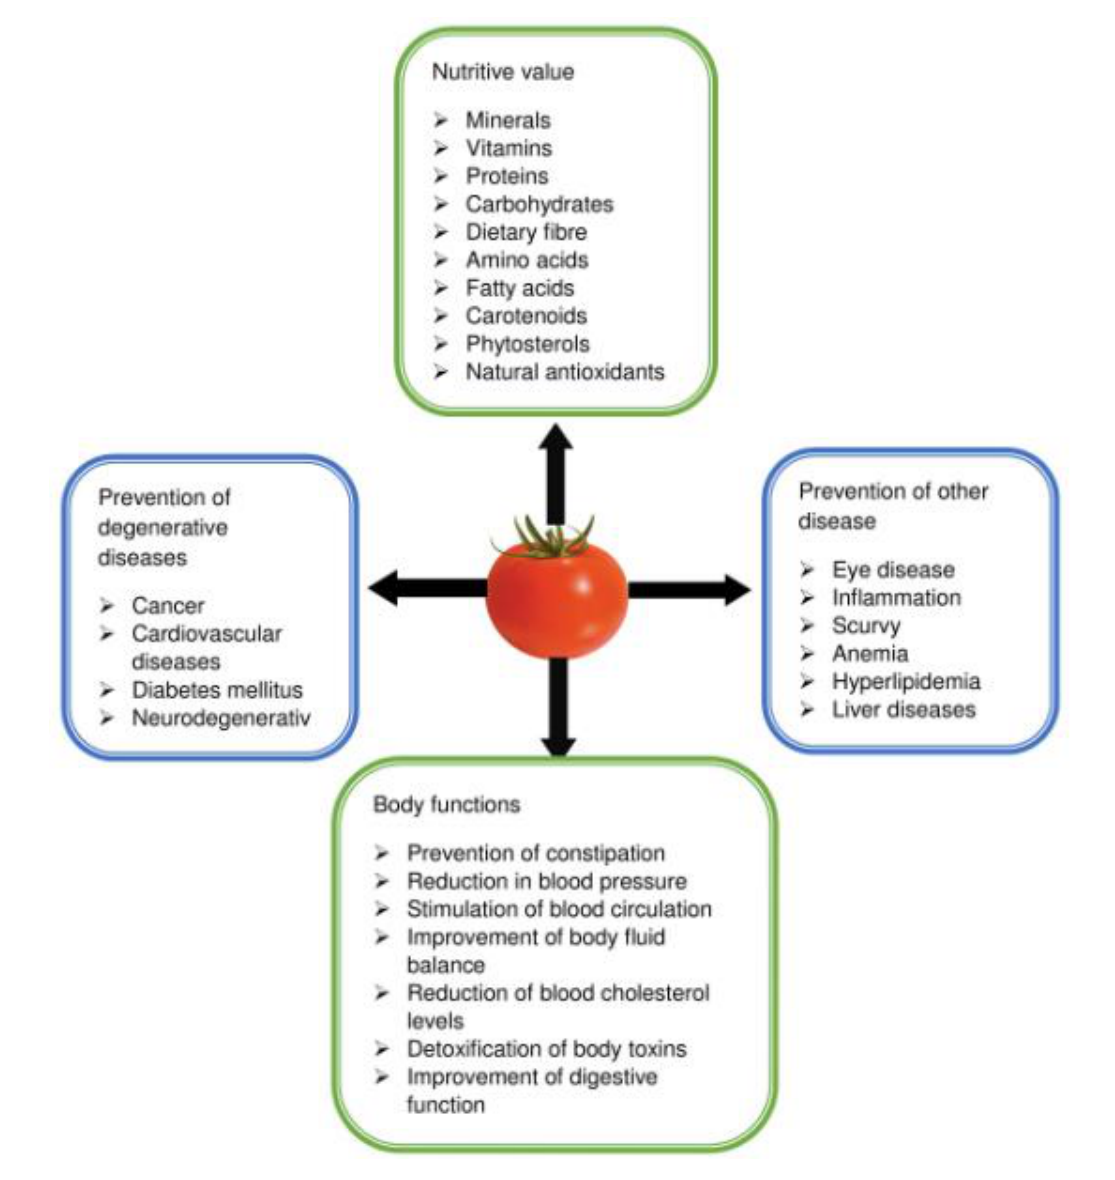
Figure 1. Summary of health benefits of tomato.